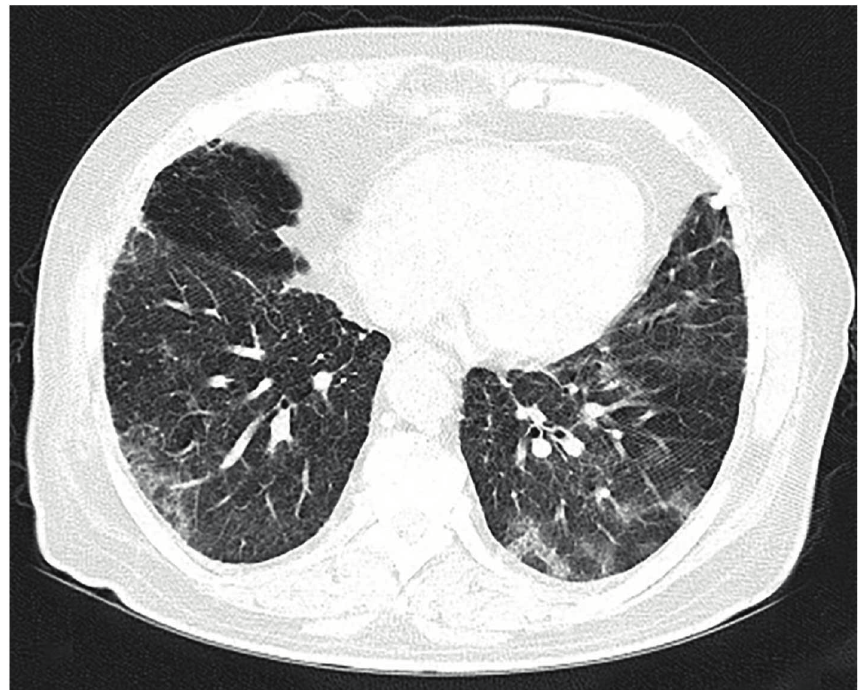
Figure 3: A 61-year-old female patient with hypertension and diabetes. Pulmonary involvement: predominancy of GGO with peripheral, pleural-based distribution. Total pulmonary involvement (PI) score and PI density index were 6 and 1.2, respectively, and she was stratified as a low-risk patient in death predictive